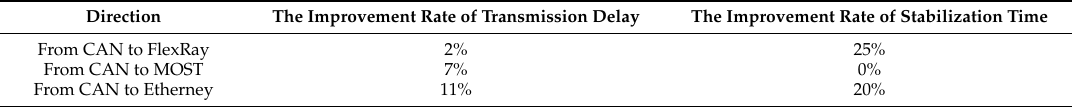
Table 3. The improvement rate of the proposed method.